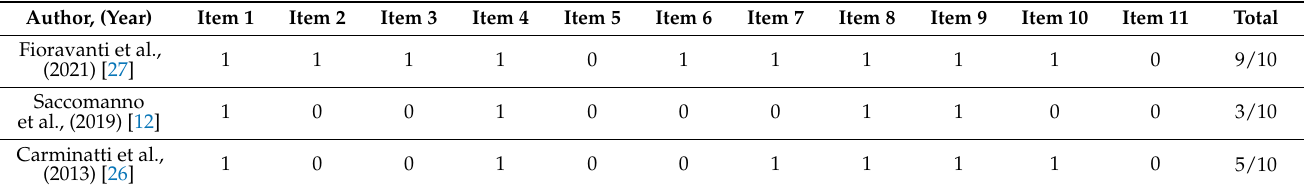
Table 3. Quality of Clinical Trials measured with the PEDro Scale.